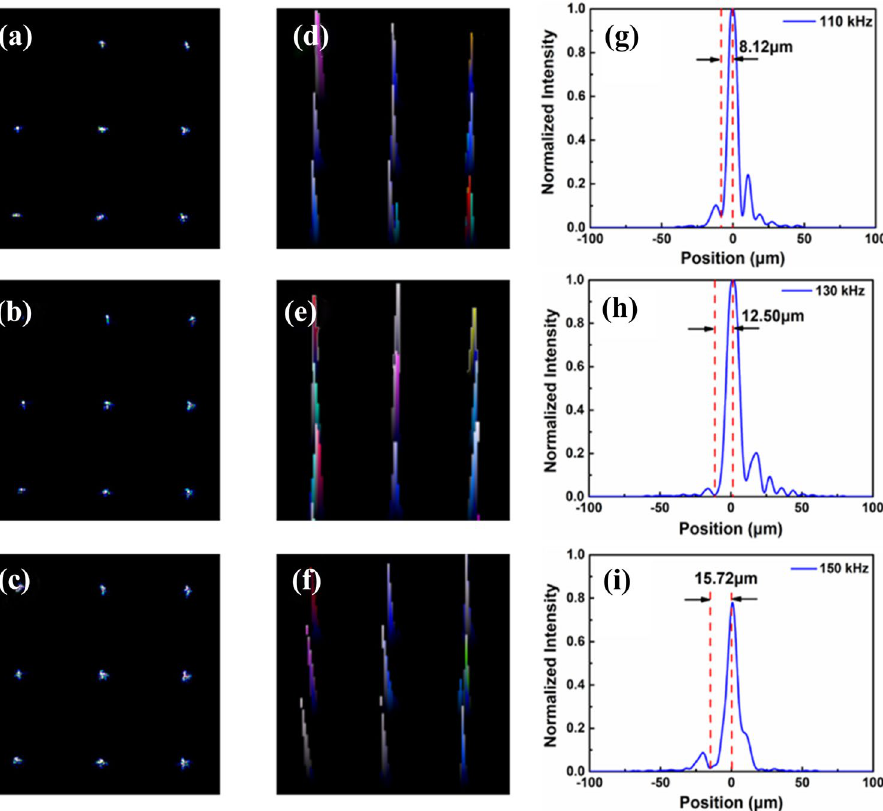
Figure 4. ( a – c ) 2D light intensity distribution for the driving frequencies of 110, 130, and 150 kHz at the standard working voltage of 2.2 V rms , respectively. ( d – f ) Corresponding 3D light intensity distribution; and ( g – i ) Normalised intensity distribution of a randomly selected focused